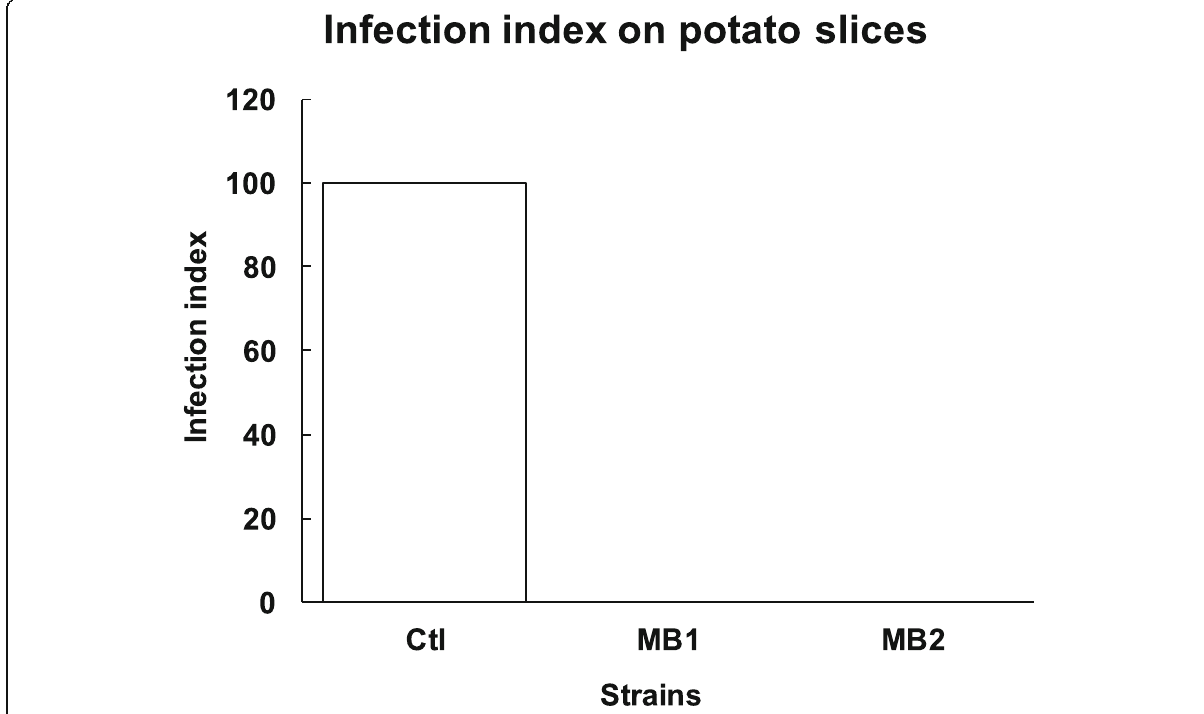
Fig. 7 Effect of bacterial antagonists against Erwinia amylovora infection on potato